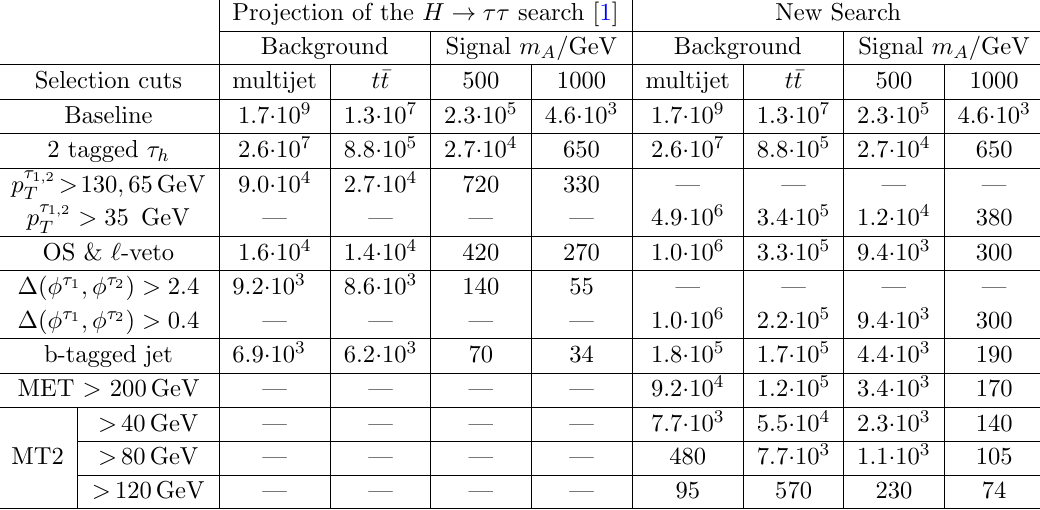
Table 1 . Cut-(cid:13)ow table for the signal and major backgrounds for the LHC H ! (cid:28)(cid:28) search (hadronic, b-tag signal region) [1] and our proposed search for H ! ~ (cid:28) ~ (cid:28) in the b (cid:22) b associated produc- tion channel of the heavy Higgs bosons. The entries represent the expected number of events at the HL-LHC. For the signal yield, we choose tan (cid:12) = 10. The two stau benchmark points correspond to ( m A = 500 GeV, m ~ (cid:28) = 225 GeV) and ( m A = 1000 GeV, m ~ (cid:28) = 475 GeV), and have BR( A ! staus) (cid:25) 15% and 9% respectively (similar for H), while M 1 = 100